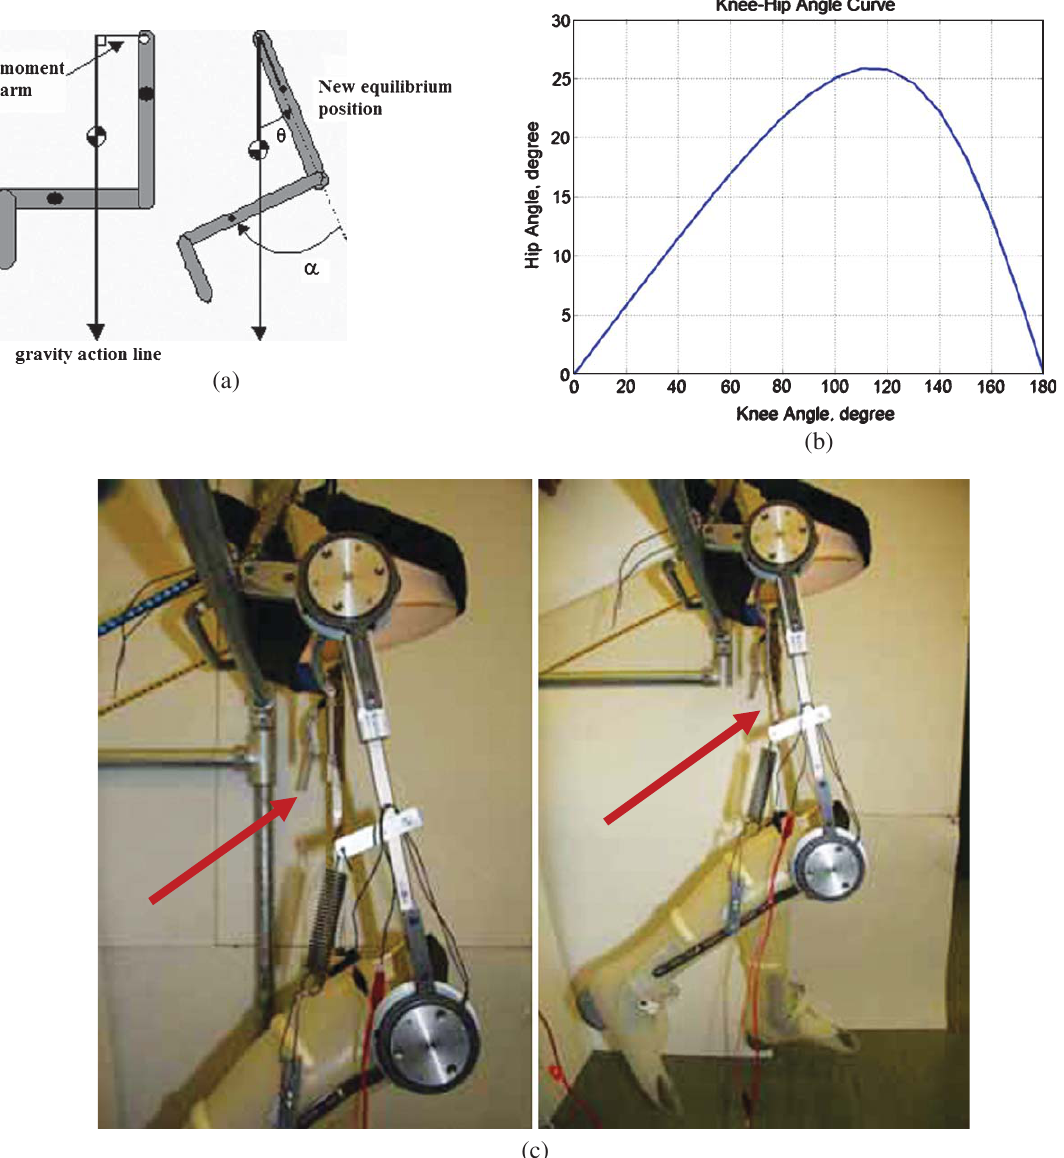
Fig. 2. (a) Hip flexion resulting from flexed knee. (b) Static relation between knee and hip flexion angle. (c) Hip flexion angle produced in the knee